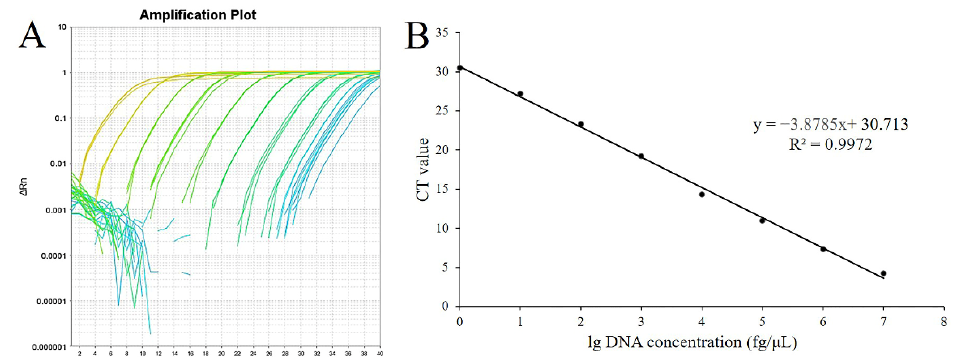
Figure 4. The standard curve for the rapid detection system of B. velezensis ZF2. ( A ), Amplification plot of real-time qPCR using different concentrations of plasmid DNA containing the target gene of the B. velezensis ZF2 (D3N19_RS13500) fragment. ( B ), Standard curves based on different concentrations of plasmid DNA and the corresponding amplified CT value. X represents the lg DNA concentration, and y represents the CT value.